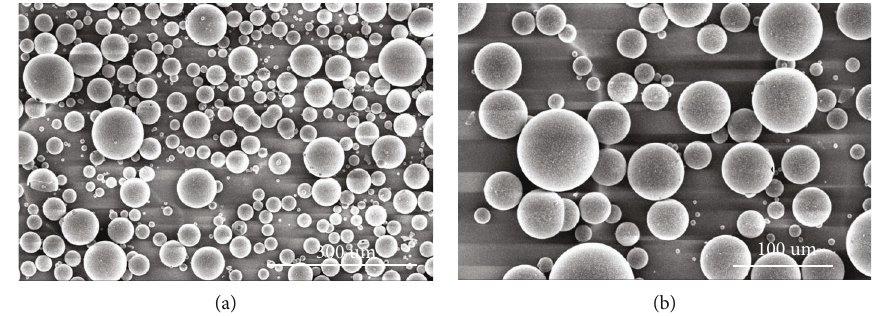
Figure 4: SEM images of K1 HGMs.